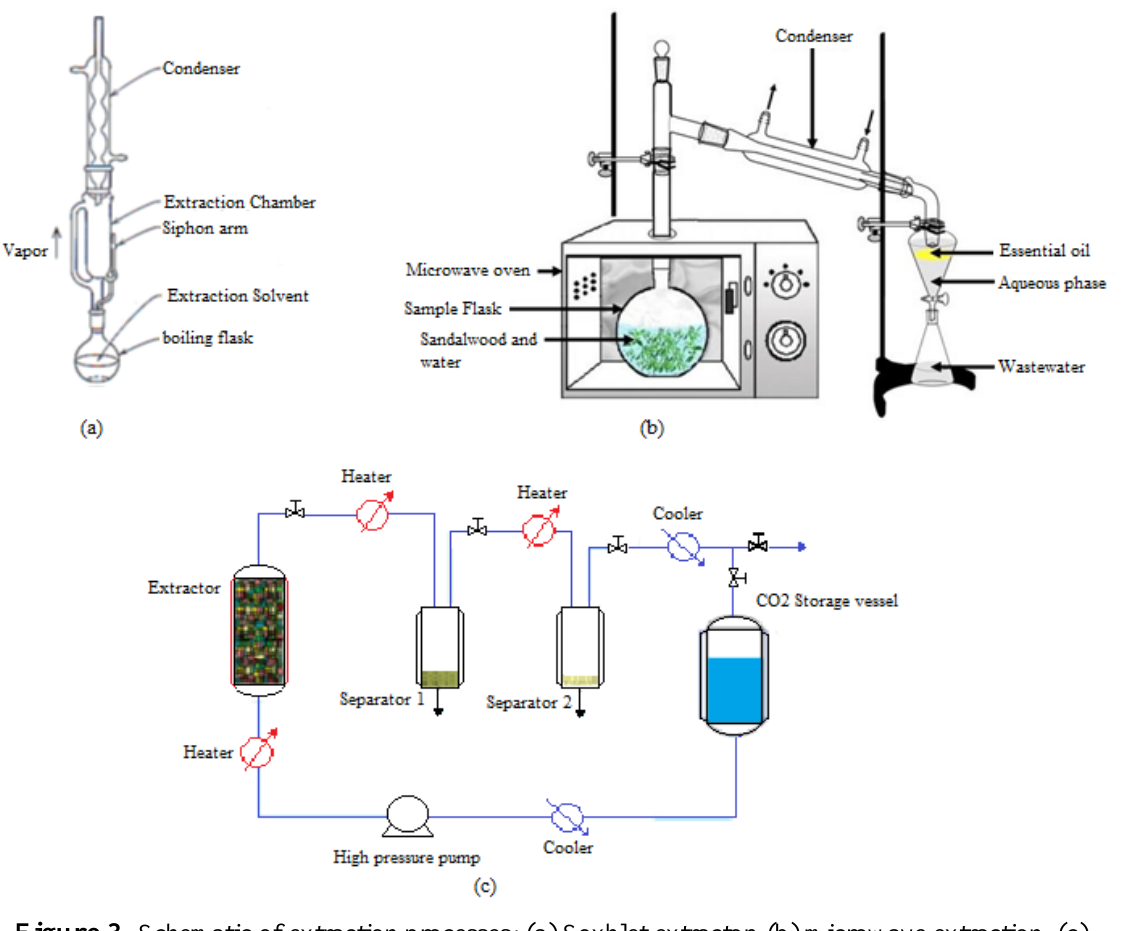
Figure 3. Schematic of extraction processes: (a) Soxhlet extractor, (b) microwave extraction, (c) supercritical fluid extraction (SFE) (Azmir et al.,